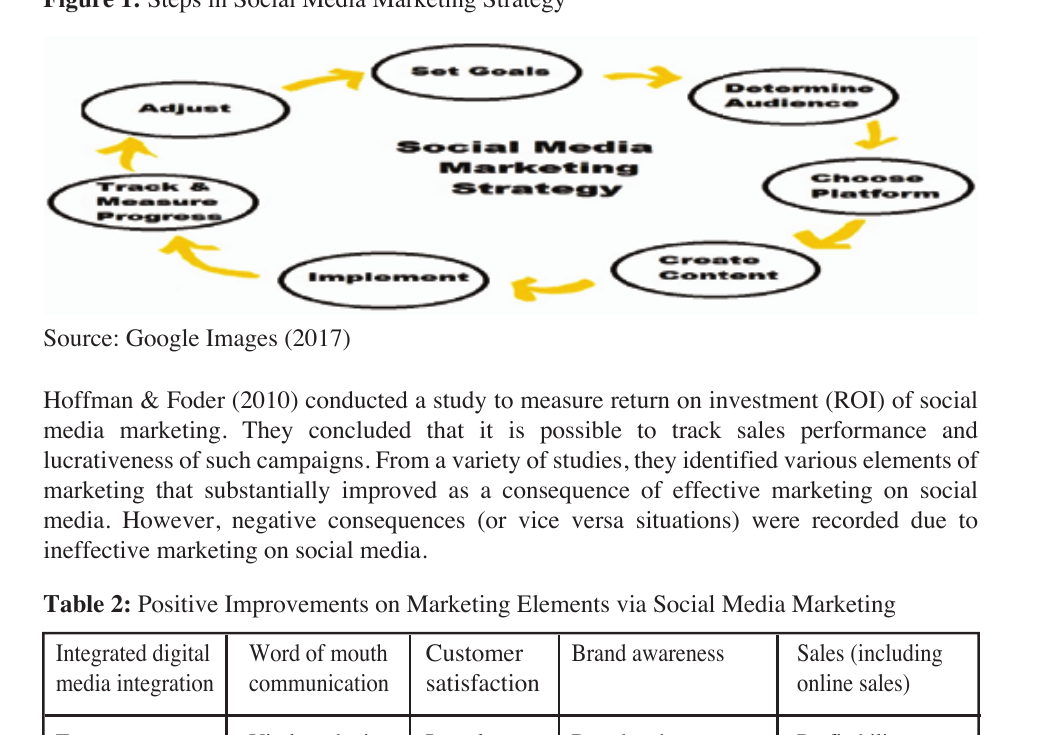
Figure 1: Steps in Social Media Marketing Strategy